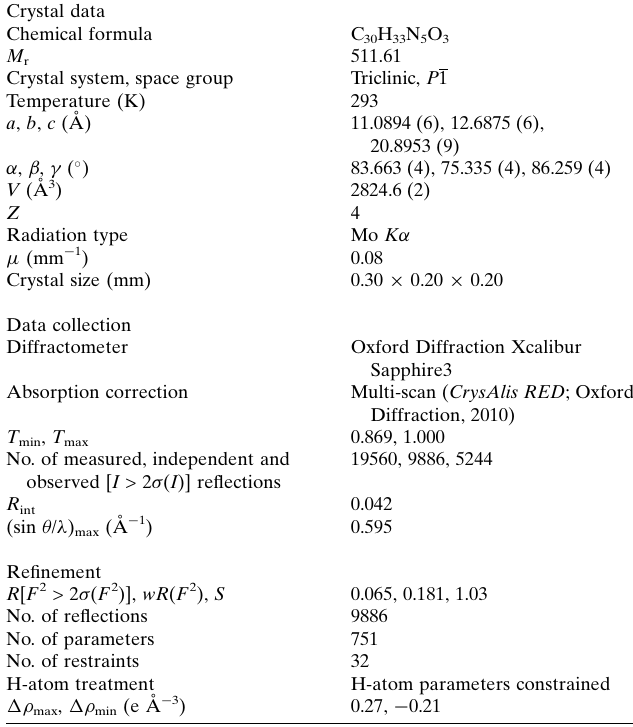
Table 2 Experimental details. Crystal data Chemical